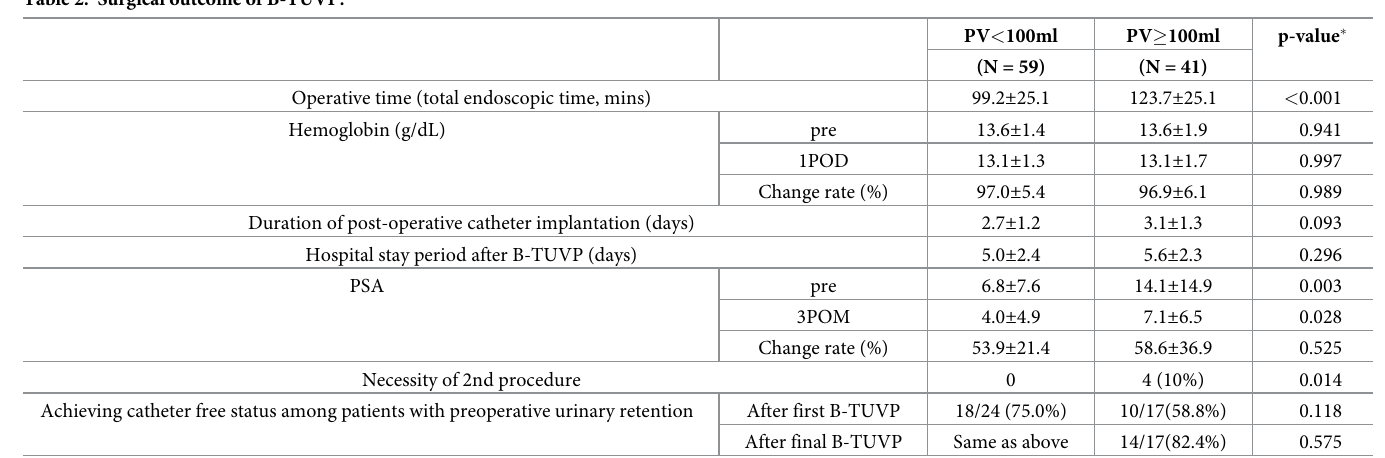
Table 2. Surgical outcome of